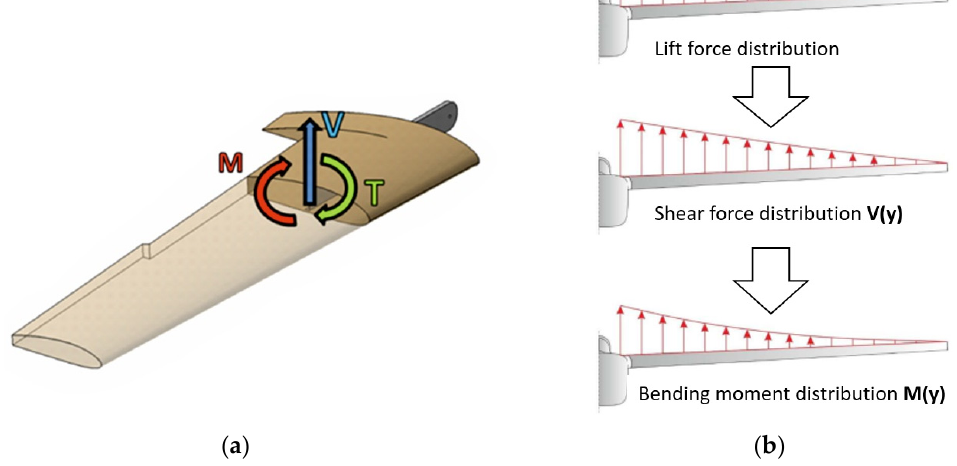
Figure 1. Wing main section load ( a ) and sample spanwise distribution of lift force, shear force and bending moment acting on the wing ( b ).